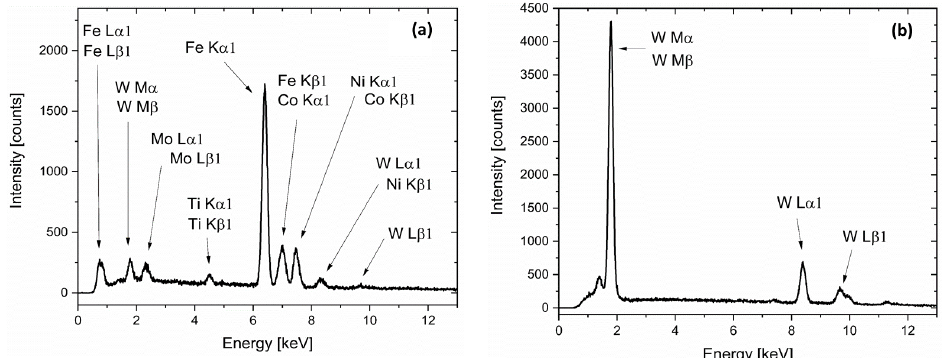
Figure 3. EDS measurements. ( a ) Spectrum of the MS1 matrix with tungsten in the background. ( b ) ( b ) Spectrum measured on a tungsten Spectrum measured on a tungsten particle.